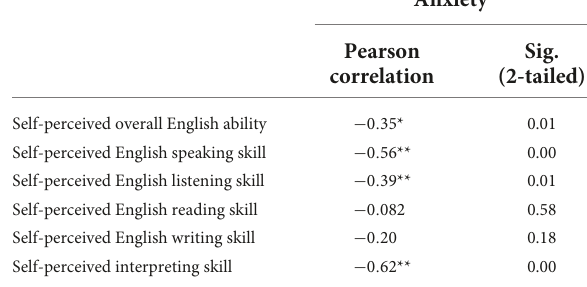
TABLE 5 Pearson product-moment correlation between interpretation classroom foreign language anxiety levels and dependency distance at a Hong Kong institution (CI test).